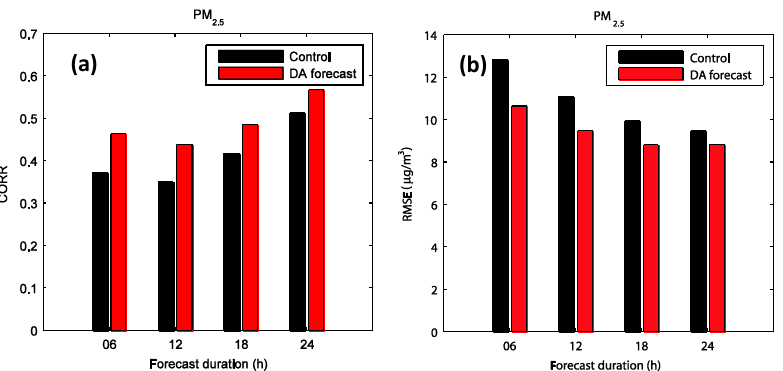
Figure 7. Correlations (a) and root-mean square errors (RMSEs in µg/m 3 ) (b) of the 2 Fig. 7. Correlations (a) and root-mean-square errors (RMSEs in µgm − 3 ) (b) of the total PM 2 . 5 concentration forecasts against observations as a function of forecast duration. The forecast is initialised at 12:00UTC. Both correlations and RMSEs are calculated against the observations from 42 stations during the period 12:00UTC, 5 May to 12:00UTC, 14 June 2010. The black bars are for the control forecast without data total PM2.5 concentration forecasts against observations as a function of forecast 3 assimilation, and the red bars for the forecast with data duration. The forecast is initialized at 12 UTC. Both correlations and RMSEs are 4 calculated against the observations from 42 stations during the period 12 UTC, 5 May to 5 12 UTC, 14 June, 2010. The black bars are for the control forecast without data 6 assimilation, and the red bars for the forecast with data assimilation. 7